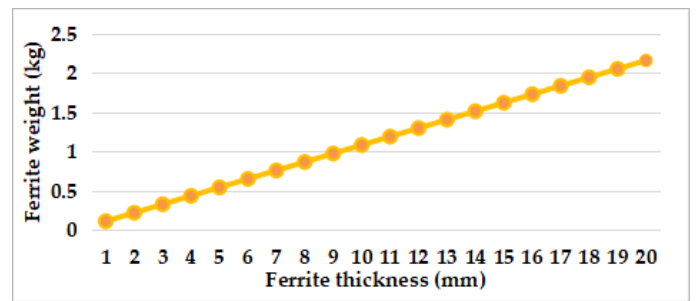
Figure 8. Ferrite weight with increasing thickness.